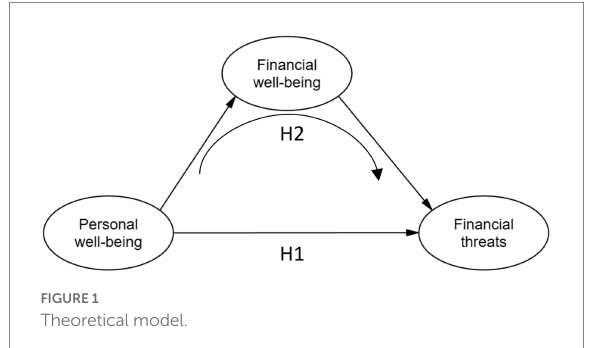
FIGURE 1 Theoretical